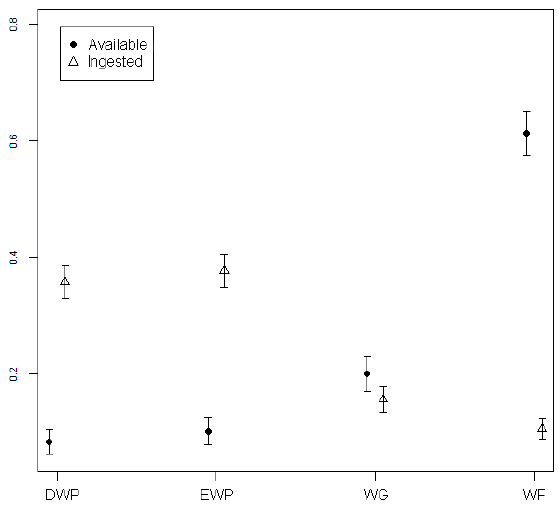
Figure 3. Ingested and available plants grouped by vegetation form in WS (EWP = Evergreen woody plants; DWP = Deciduous woody plants; WF = Wild forbs; WG = Wild graminoids). Table 2. Selection ratio ( w i ) of Capreolus capreolus italicus on botanical families in dry season (DS) and in wet season